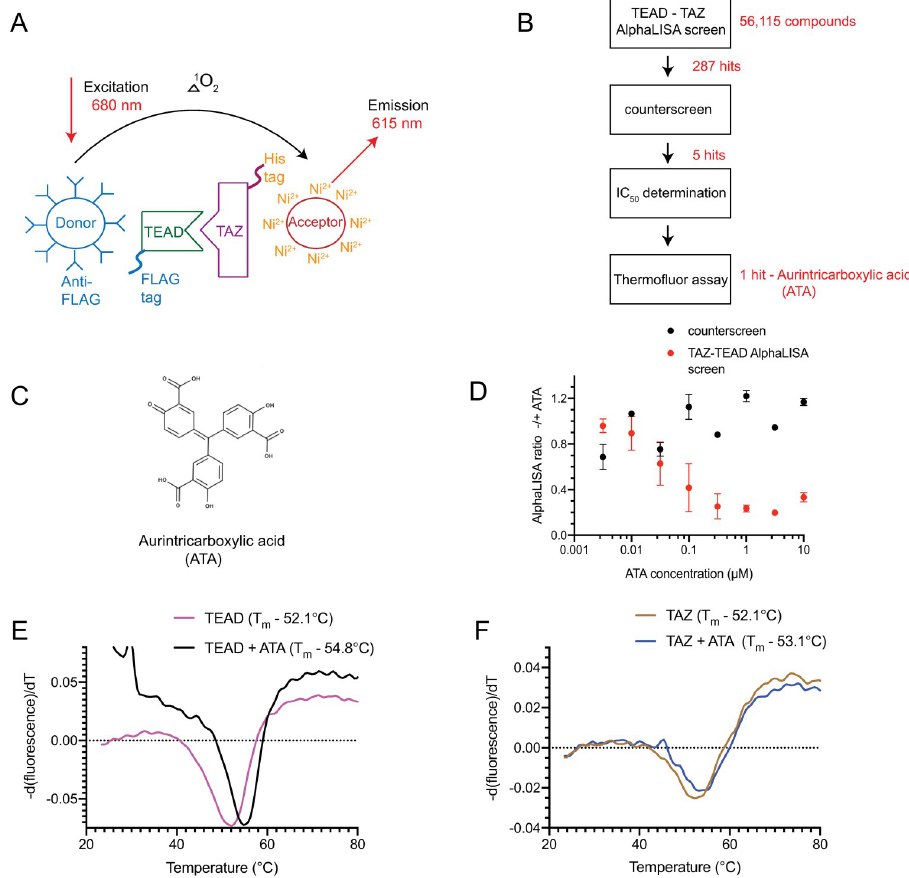
Fig 1. TAZ-TEAD AlphaLISA assay. A, A schematic showing the TAZ-TEAD AlphaLISA assay design. The interaction between the tagged, full-length, TAZ and TEAD proteins brings the donor and acceptor beads close enough to allow singlet oxygen transfer, which generates an emission signal at 615 nm. B, Flowchart of the screening strategy, 56,115 compounds were screened using the TAZ-TEAD AlphaLISA screen. Filtering the hits via a counterscreen followed by IC 50 determination and assessment using a ThermoFluor assay identified aurintricarboxylic acid (ATA) as a disruptor of the TAZ-TEAD complex. C, The molecular structure of ATA. D, Dose-response curves obtained after titration of ATA either in the TAZ-TEAD AlphaLISA assay or in the counterscreen; a FLAG-His fusion peptide was used in the counterscreen. E and F, ThermoFluor assays measuring the melting temperatures (T m ) of full- length TAZ or TEAD in the presence of ATA. Data are representative of three independent experiments performed using technical duplicates.